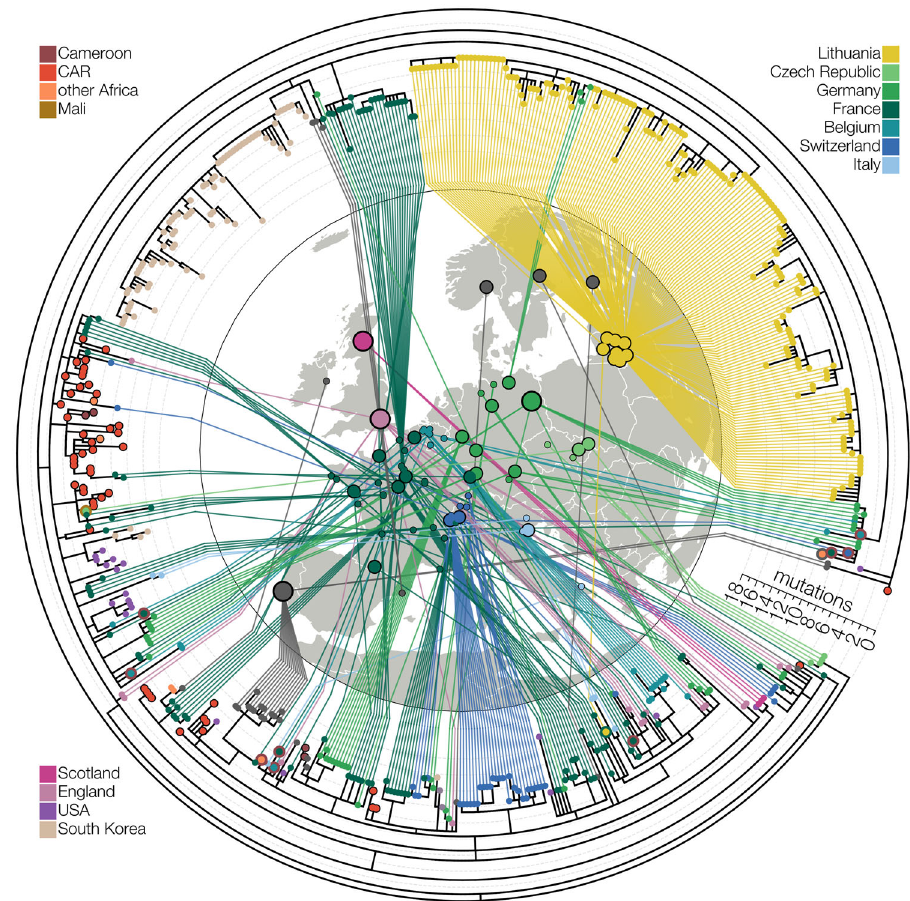
Fig. 2 Maximum-likelihood tree of lineage B.1.620 in Europe. Relationships between B.1.620 genomes, coloured by country of origin (same as Fig. 1) with a thicker coloured outline indicating the country of origin for travel cases. At least ten genomes shown (samples collected in Belgium, Switzerland, France and Equatorial Guinea) are from individuals who returned from Cameroon, one is from a traveller returning from Mali and one Lithuanian case returned from France. Genomes from the Central African Republic (CAR) and Czechia (returning traveller from Mali) are descended from the original B.1.620 genotype, while the genome from Equatorial Guinea is already closely related to genomes found in Europe and happens to be a travel case from Cameroon. Each genome is connected to the available geographic location in Europe with the smallest circles indicating municipality-level precision, intermediate size corresponding to county-level information (centred on county capital) and largest circle sizes indicating country-level information (centred on country capital). Countries are assigned the same colours as in Figs. 1 and